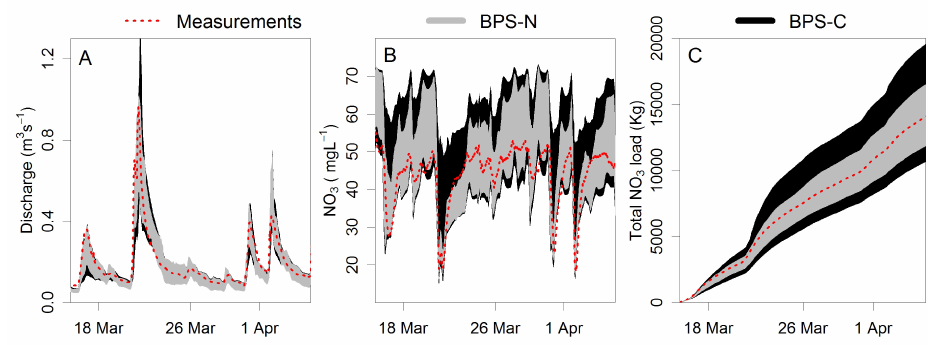
Fig. 12. Simulation results of BPS-N and BPS-C for discharge (A) , nitrate concentration via a flow route mixing analysis (B) , and cumulative nitrate load (C)